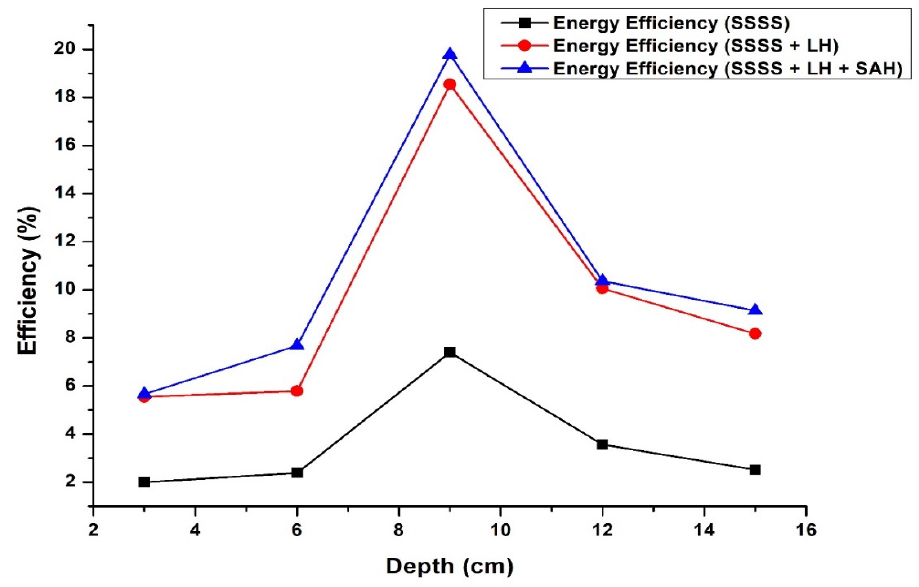
Figure 9. Variation of efficiency at different depth.